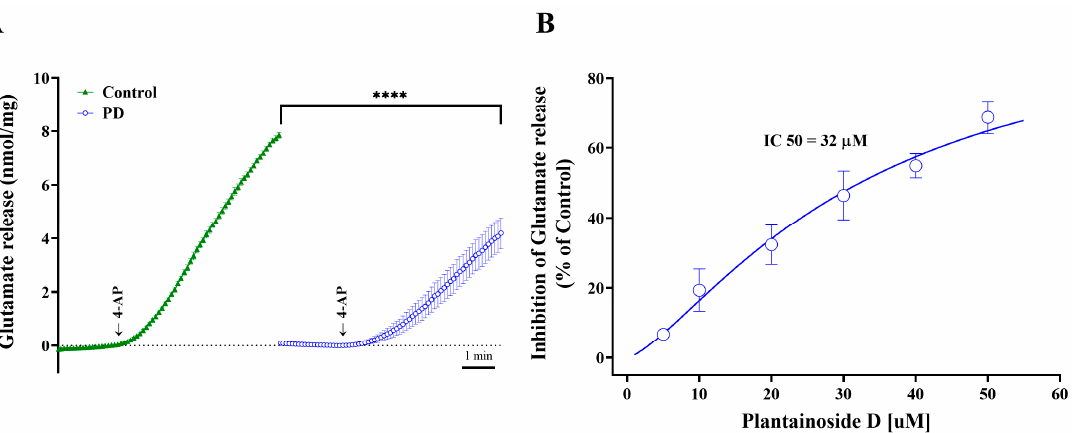
Figure 1. Schematic diagram of the experimental design and treatment schedule. EGTA treatment is represented in green. Abbreviations: MT, mitochondria; ER, endoplasmic reticulum; SVs, synaptic vesicles.